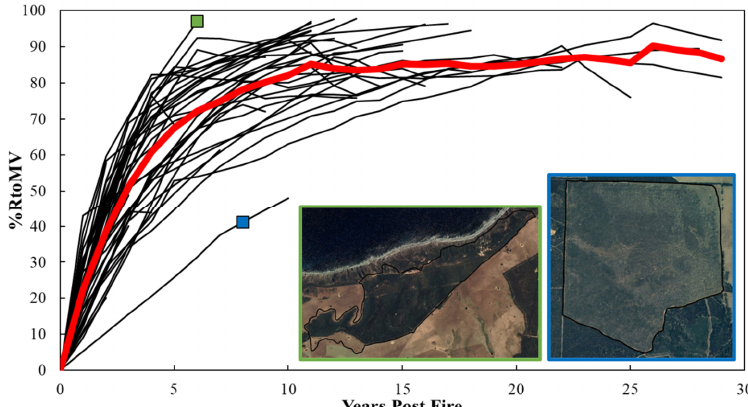
Figure 9. Average post-fire recovery ( %RtoMV ) trajectories for all recorded fires (≥ 1 km 2 ) during the Landsat record (1988–2020). Only burned pixels ( dNBR ≥ 100) analyzed. Red: overall average recovery. Green: Google Earth image six years after the fastest recovering fire. Blue: eight years after slowest recovering fire. Black line indicates fire polygon area for both fires [45]. Note that a fire can only reach 100 %RtoMV if every burned pixel comes to its mNBR value in the same post-fire year.